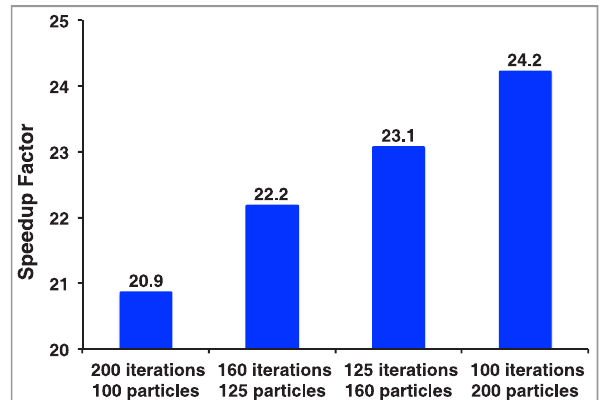
Figure 9. Runtime dependence on the number of particles and the number of iterations. A series of optimizations are compared in which the number of calculations (and thus the total time required) on the CPU is constant, and the speedup factor is reported as the ratio of the time required using the GPU to the time required using the CPU alone. The benefit of using the GPU is enhanced when individual GPU tasks are larger (more particles), allowing fewer CPU-GPU communica- tion steps.